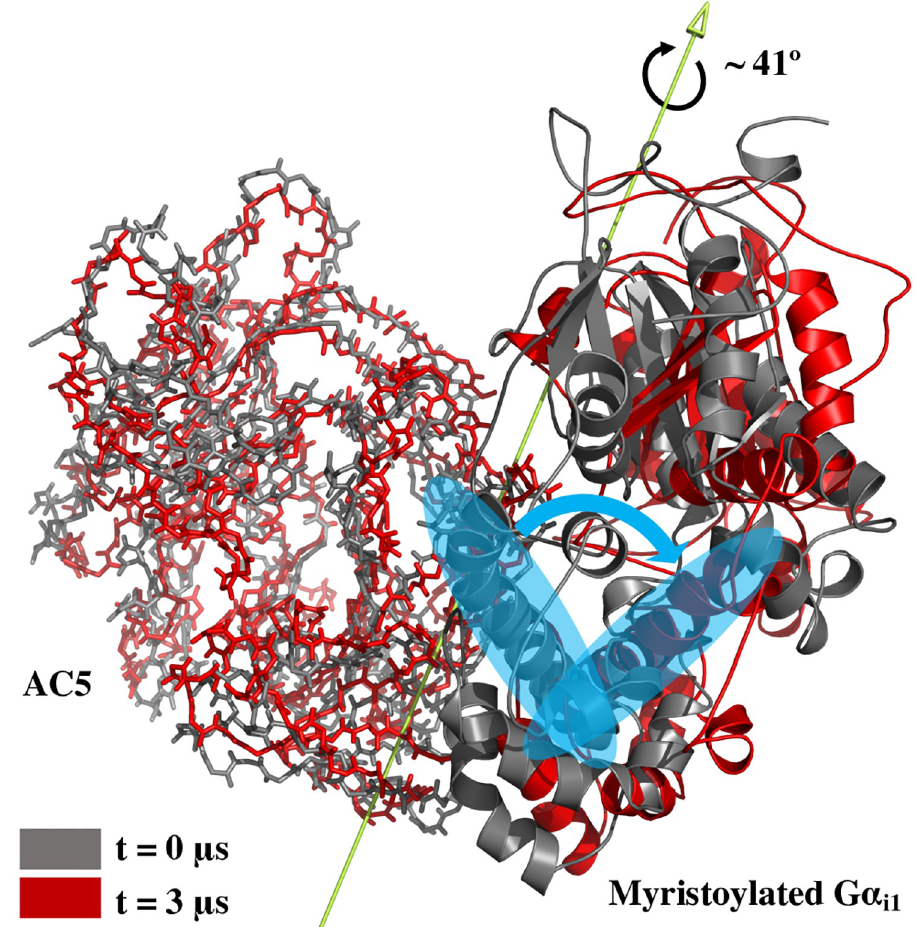
Fig 3. Subunits orientation in AC5:G α i 1 complex. The protein conformation sampled in the last frame of the holo AC5:G α simulation (shown in red) was compared with the first frame (shown in gray) of the same trajectory using i 1 the DynDom software. The rotational axis around which the G α i 1 rotate of about 41˚, identified by the DynDom analysis, is also shown. The rotational motion of a single helix is highlighted in order to visually identify the respective rotational mode.